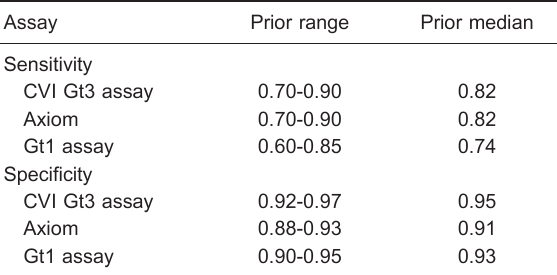
Table 1. Prior 95% range and median for sensitivity and